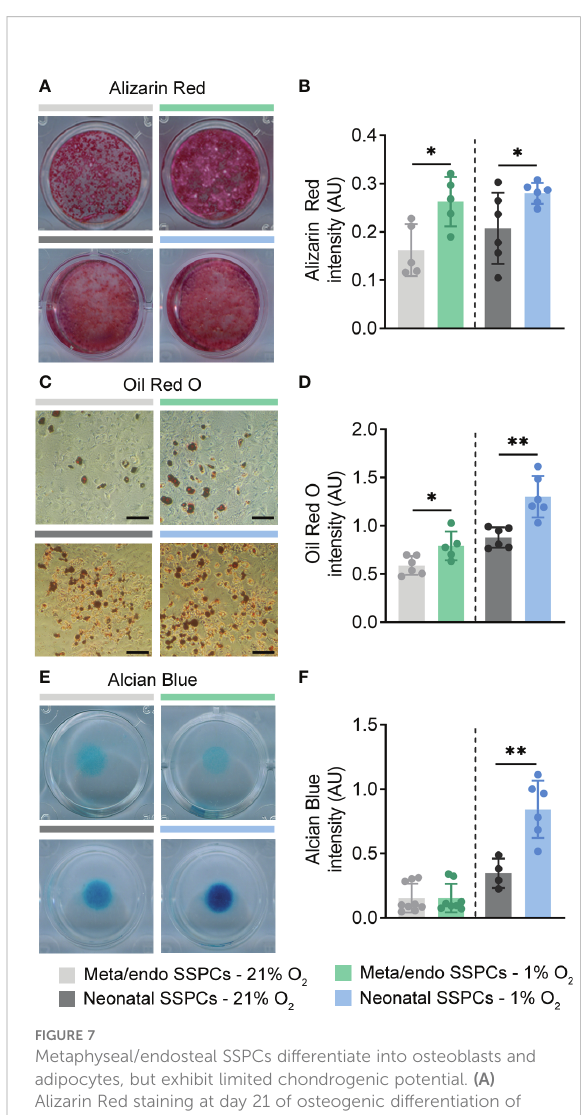
FIGURE 7 Metaphyseal/endosteal SSPCs differentiate into osteoblasts and adipocytes, but exhibit limited chondrogenic potential. (A) Alizarin Red staining at day 21 of osteogenic differentiation of metaphyseal/endosteal (upper panels) and neonatal SSPCs (lower panels), expanded in 21% or 1% O 2 (n=5-6). (B) Quanti fi cation of Alizarin Red staining intensity at day 21 of osteogenic differentiation (n=5-6). (C) Oil Red O staining at day 14 of adipogenic differentiation of metaphyseal/endosteal (upper panels) and neonatal SSPCs (lower panels), expanded in 21% or 1% O 2 (n=5-6). Scale bar is 100 µm. (D) Quanti fi cation of Oil Red O staining intensity at day 14 of adipogenic differentiation (n=5- 6). (E) Alcian Blue staining of micromass cultures at day 9 of chondrogenic differentiation of metaphyseal/endosteal (upper panels) and neonatal SSPCs (lower panels), expanded in 21% or 1% O 2 (n=4-9). (F) Quanti fi cation of Alcian Blue staining intensity at day 9 of chondrogenic differentiation (n=4-9). Data are shown as mean ± SD. *p<0.05, **p<0.01 (Student ’ s t